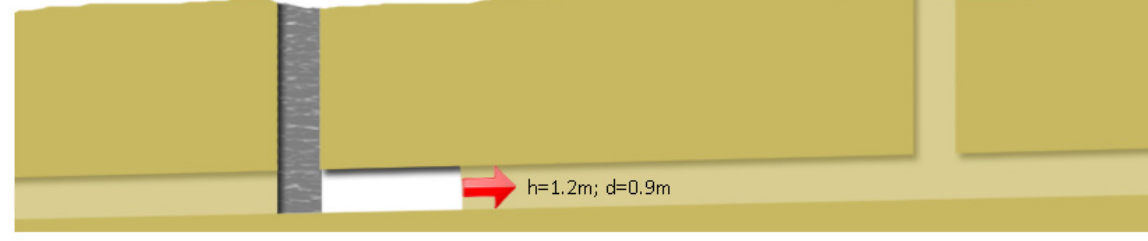
Figure 23. Tunnel digging.